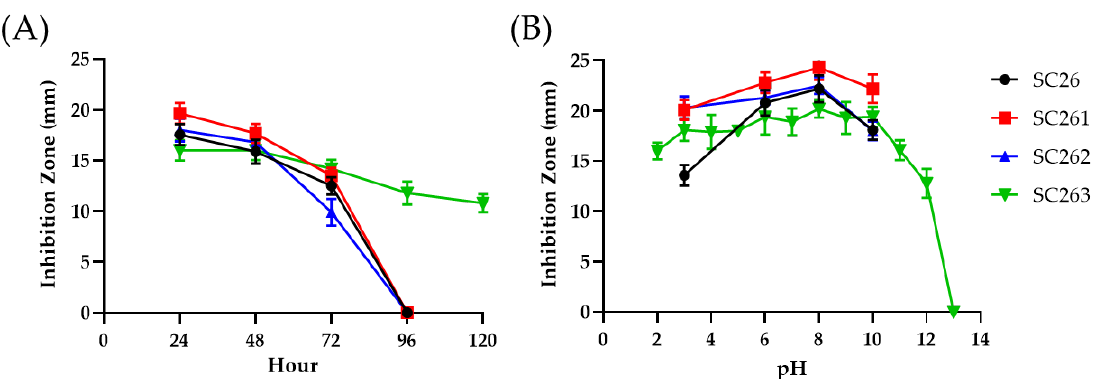
Figure 2. Antifungal characteristics of SC26 and its derivatives. The antifungal activity of SC26 and its derivatives was examined using different fermentation hours until day 5 ( A ) and treated under different pH conditions from 24 h cultured broth ( B ). All inhibition zones against C. albicans were measured.